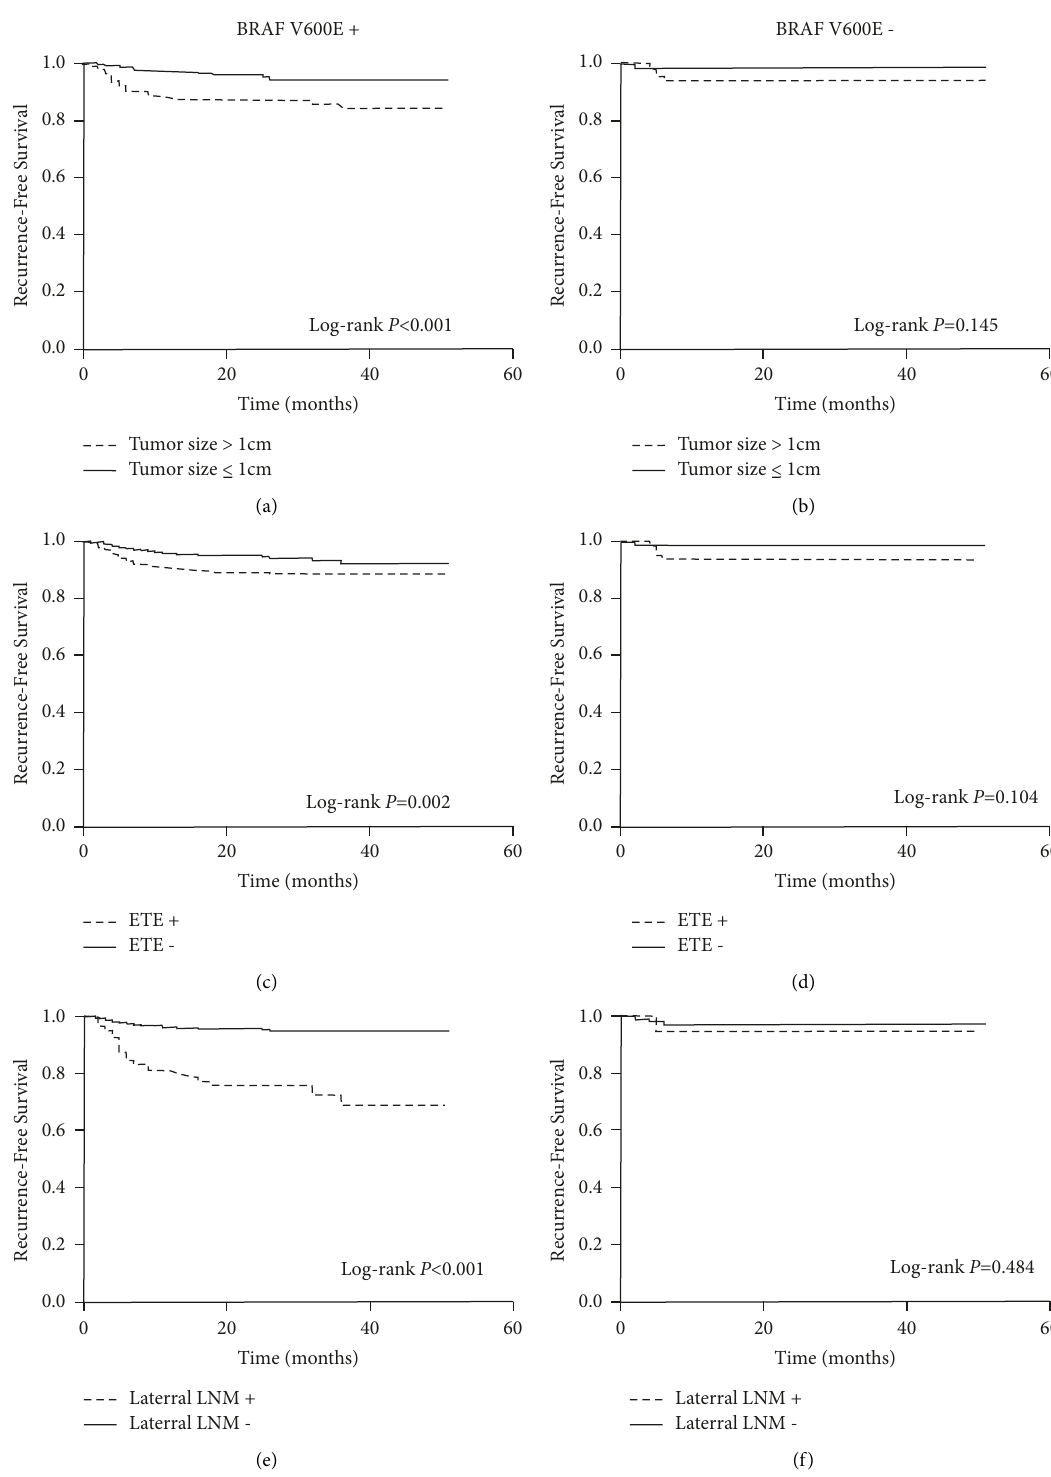
Figure 2: Kaplan–Meier survival analysis of disease recurrence-free survival of patients in the BRAF V600E-positive group (a, c, e) and the negative group (b, d, f), stratified by tumor size, ETE, and lateral